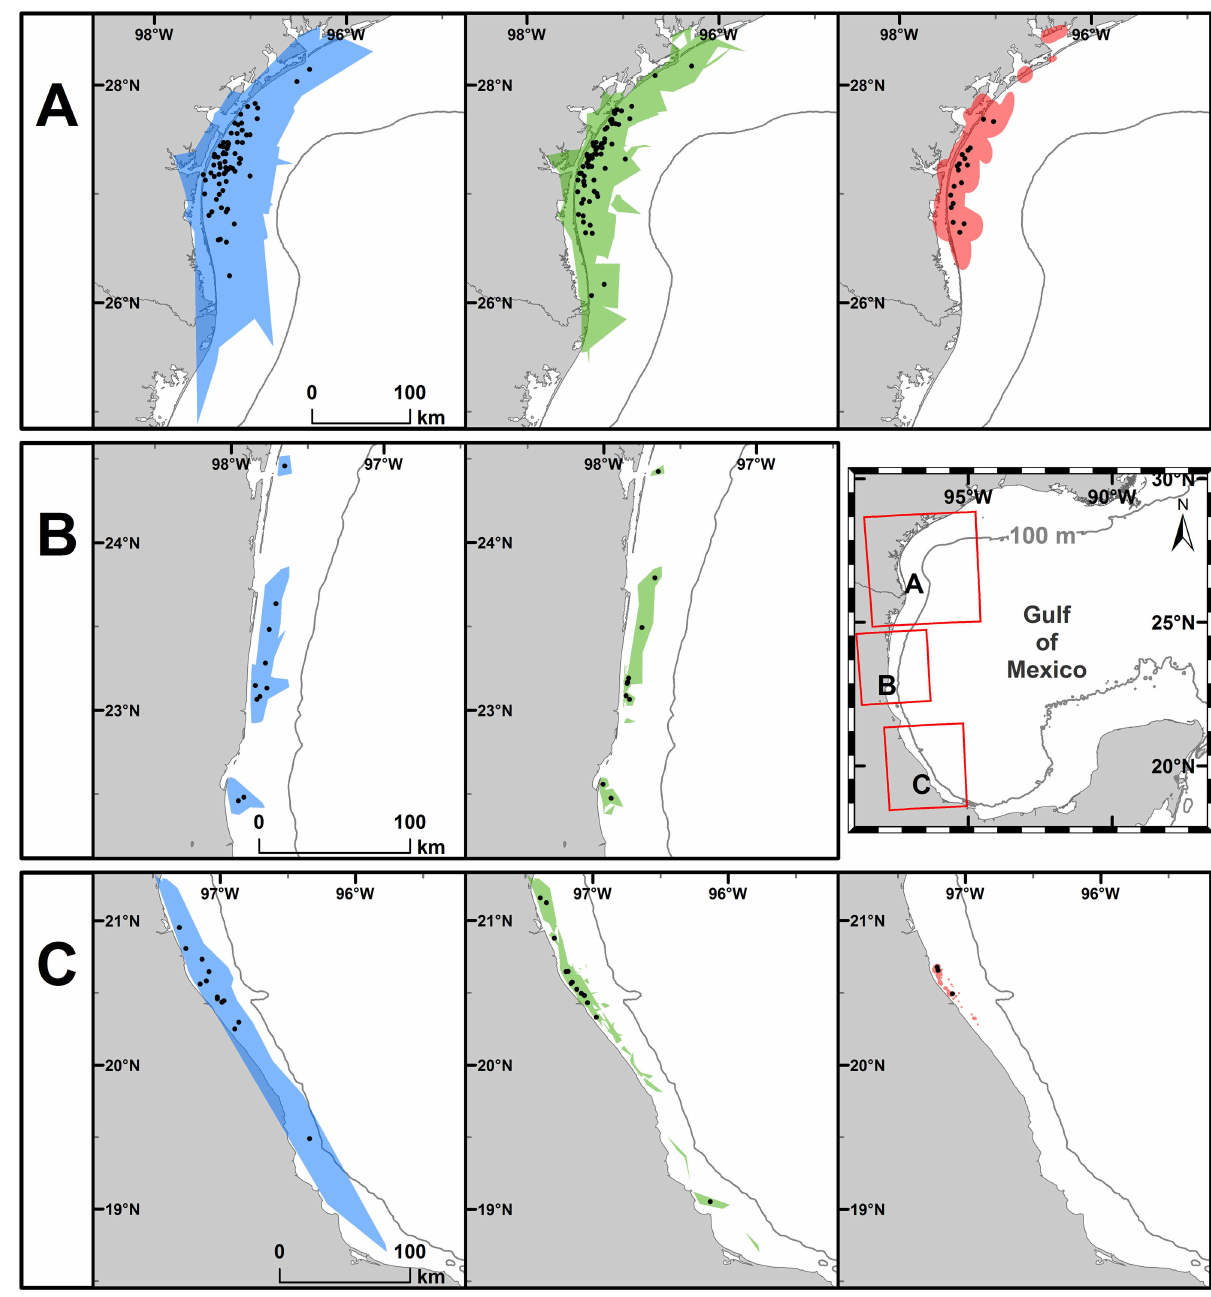
Fig 3. Home range [Minimum Convex Polygon (MCP) and α -Hull] and core use area [(Kernel Density Estimate (KDE)]. MCP (blue), α -Hull(green), and 50% KDE (red), with all centroids (•) in inter-nestinghabitat for Kemp’s ridleyturtles tracked after nestingat (A) Padre Island NationalSeashore, Texas, USA during1998 through 2013 (n = 58), (B) RanchoNuevo, Tamaulipas, Mexico during2010 and 2011 (n = 9), and (C) Tecolutla, Veracruz, Mexico during2012 and 2013 (n = 11). Note that it was not possibleto estimate KDEs for RN since a cutoff of at least 20 days with mean daily locationswas used and no turtles met that